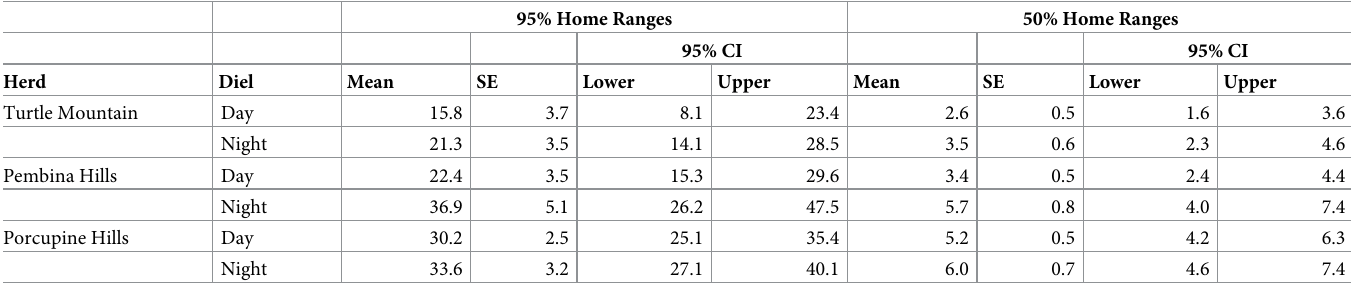
We analyzed habitat selection within landscapes defined by 1 km buffers common to all female elk in each study area. We observed single interval movements well in excess of 1 km, with the maximum observed 8.5, 12.8, and 9.0 km in a single 4 hr interval for Turtle Mountain, Pem- bina Hills, and Porcupine Hills, respectively. Mean over all herds, including intervals with < 25 m net displacement, was 585 m ± 791 SD. By study area, mean movements were 572.4 m ± 268 pine Hills, respectively. Movements were highly skewed, with nearly 20% of movements exceeding 1 km and 90 th percentile distance of 1.6 km. However, the representation of each Table 2. Mean 95% and 50% female elk home range size (km 2 ) by herd and diel period, North Dakota, USA during